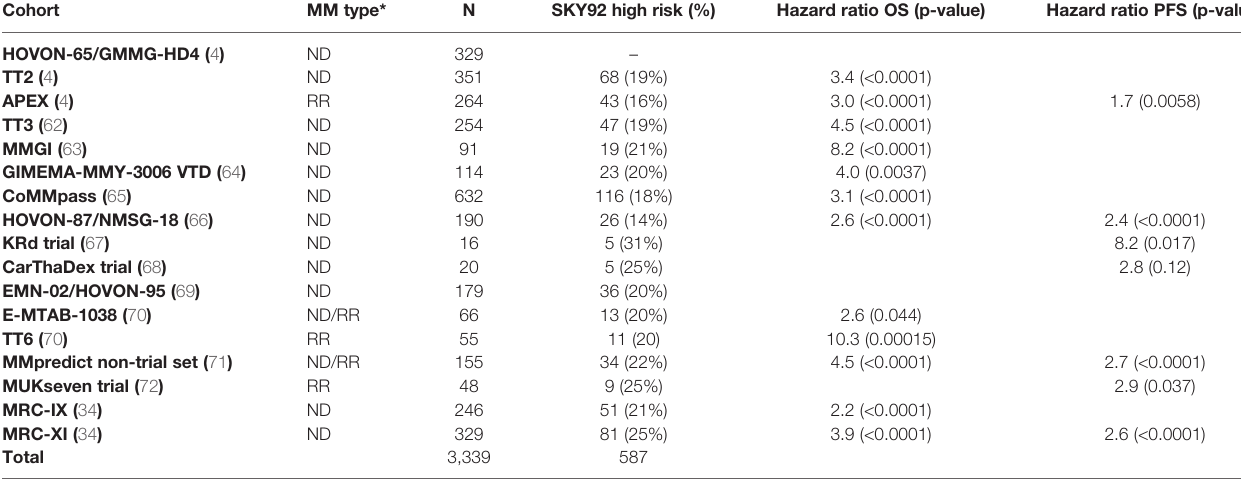
TABLE 2 | SKY92 clinical validation